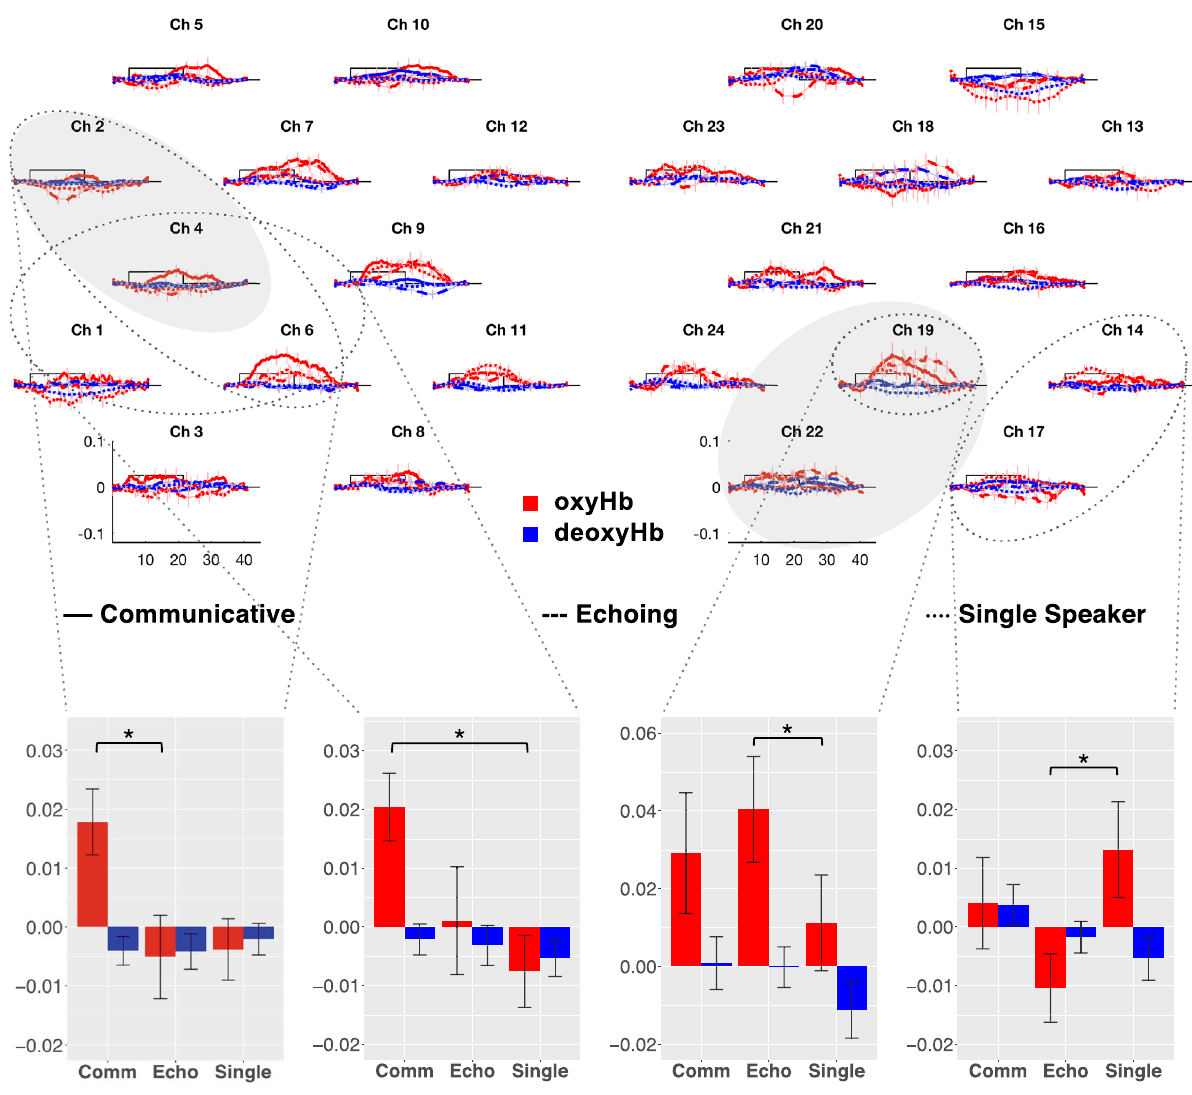
Figure 1. Grand average of oxyHb and deoxyHb. Concentration changes over each channel, averaged across all blocks for all three conditions. Channels are plotted in the layout shown in Fig. 2C. The x-axis represents time in seconds, the y-axis concentration in mmol*mm. The rectangle along the x-axis indicates time of stimulation in seconds. Red and blue colors represent oxyHb and deoxyHb concentrations, respectively. Error bars indicate standard errors of the means. The grey shaded area shows the spatial clusters in which the main ANOVA-based permutation yielded differences across conditions. The bar plots show the significant differences obtained in the clusters (encircled with dotted lines) identified by the follow-up pairwise permutation tests (the third, uncompared condition is shown for